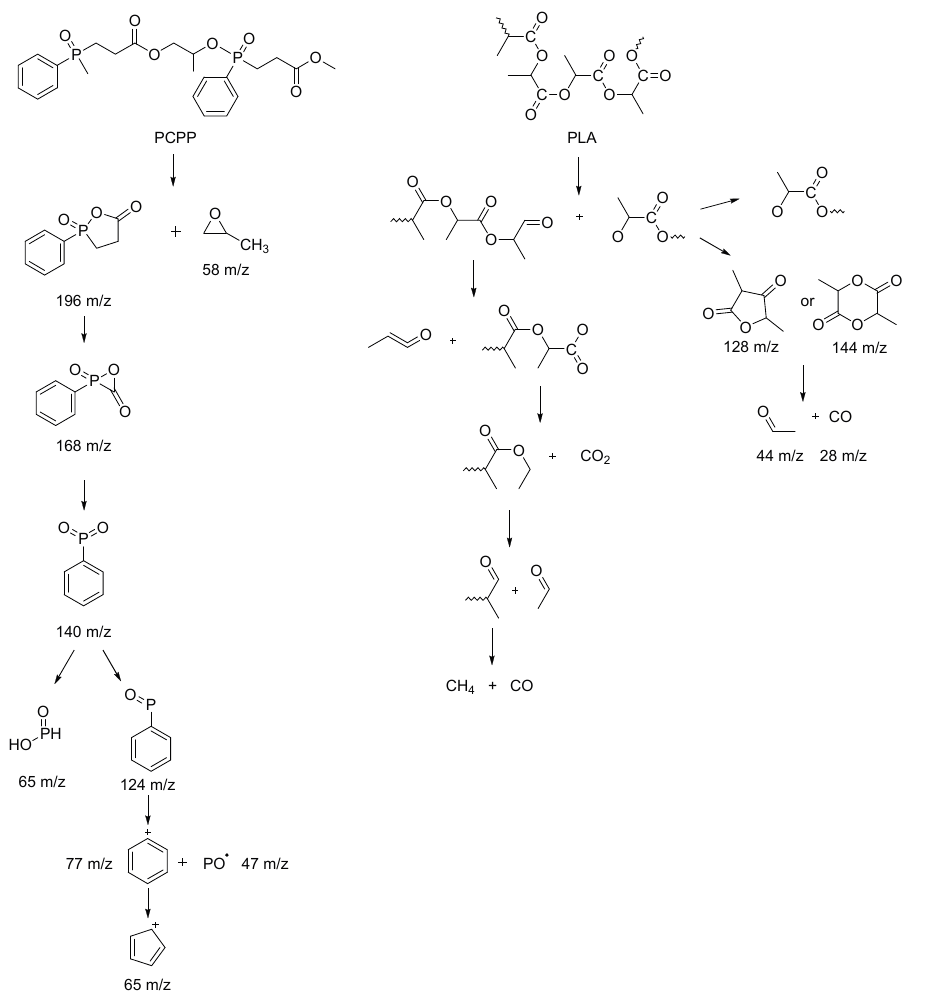
Scheme 5. Simplified degradation pathways of polylactide (PLA) and phosphorus based polymer (PCPP)